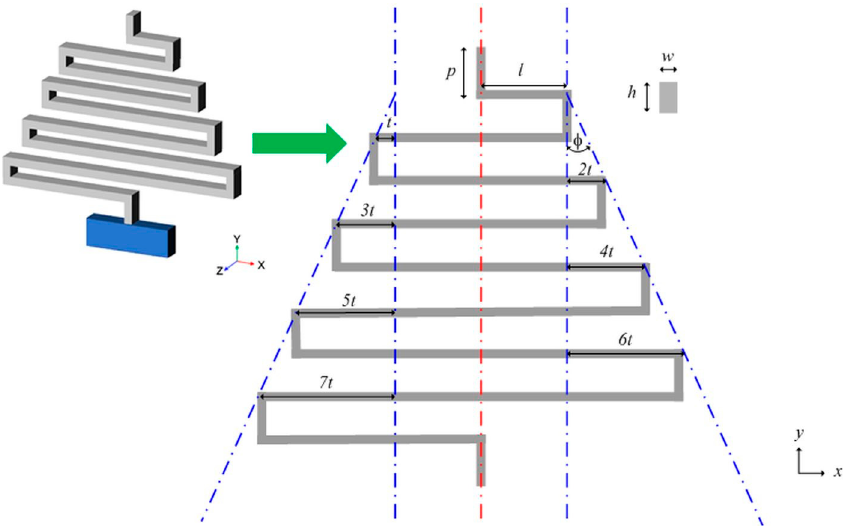
Figure 1. Awl ‐ shaped serpentine microspring (ASSM) model.